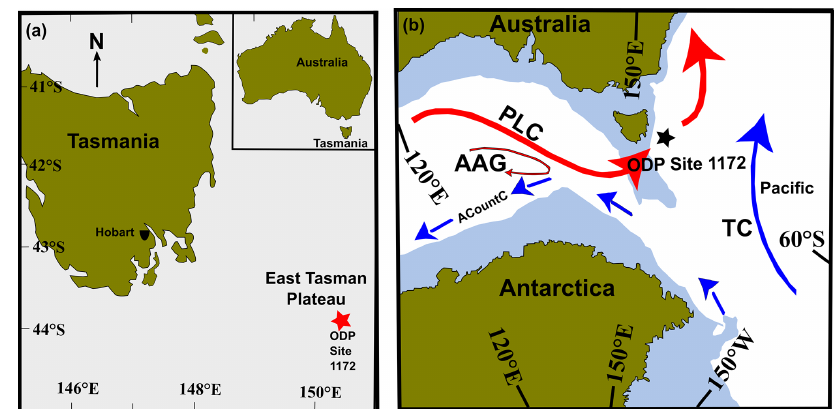
Figure 1. (a) Location of the East Tasman Plateau (ODP Site 1172; red star) and present-day Tasmania (Quilty, 2001). The Tasmania landmass is shown in green and the submerged ODP Site 1172 in grey, at a water depth of ∼ 2620m. (b) Early Oligocene palaeogeography and palaeoceanography of the Tasmanian Gateway. ODP Site 1172 is marked by a five-pointed black star. Surface currents are modified after reconstructions by Stickley et al. (2004). TC: Tasman current, PLC: proto-Leeuwin current, ACountC: Antarctic Counter Current, AAG: Australo-Antarctic Gulf. Solid red arrows indicate warmer ocean currents from the AAG, and solid blue arrows indicate cooler ocean currents. Arrow size indicates the relative strength of the current. Figure is modified after Hoem et al.